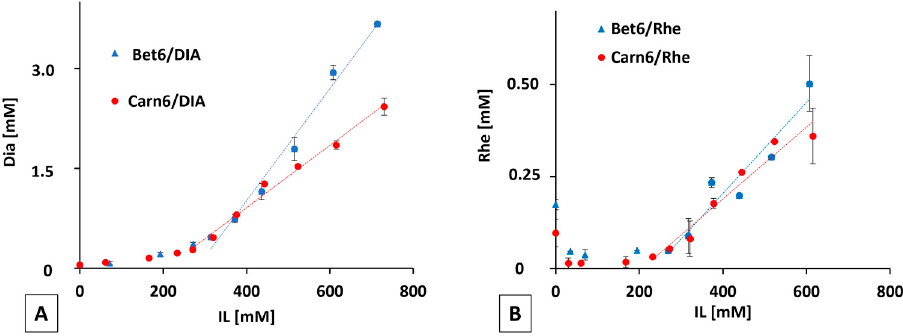
Figure 3. Evaluation of the apparent solubility of ( A ) DIA and ( B ) Rhe in the presence of ILs. Each point is the mean ± SD of three values.